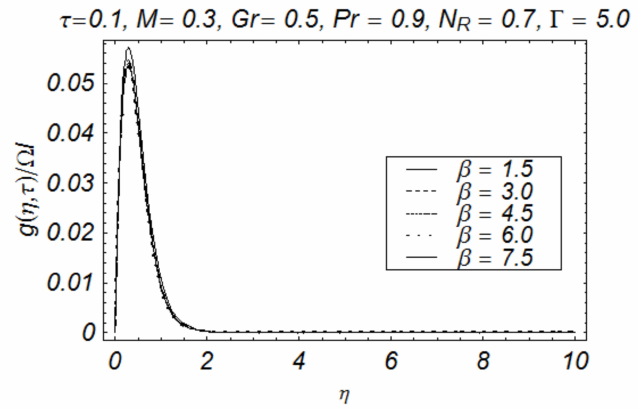
Figure 9. Indication of β on primal velocity.